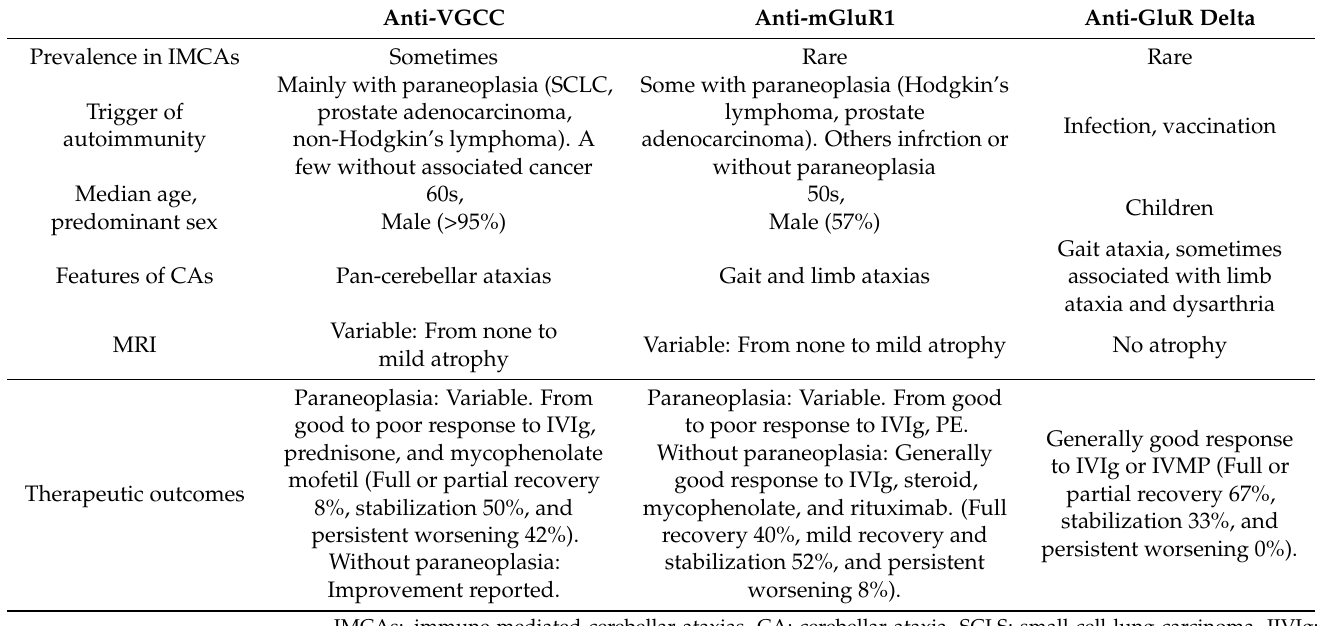
Table 1. Clinical profiles of anti-VGCC, anti-mGluR, and GluR delta antibodies-associated cerebel- lar